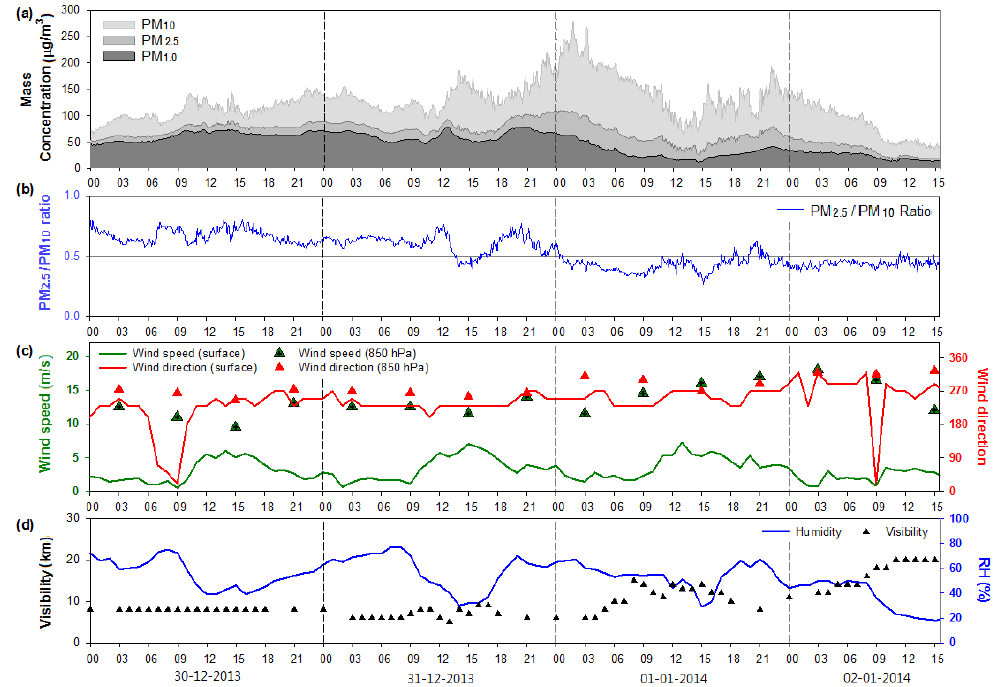
Figure 2. Time series of ( a ) PM 10 , PM 2.5 , and PM 1.0 mass concentrations; ( b ) PM 2.5 / PM 10 ratio; ( c ) wind direction and wind speed ( ─ : surface (Seoul), △ : 850 hPa (Osan)); and ( d ) humidity and visibility from 30 December 2013 to 2 January 2014.